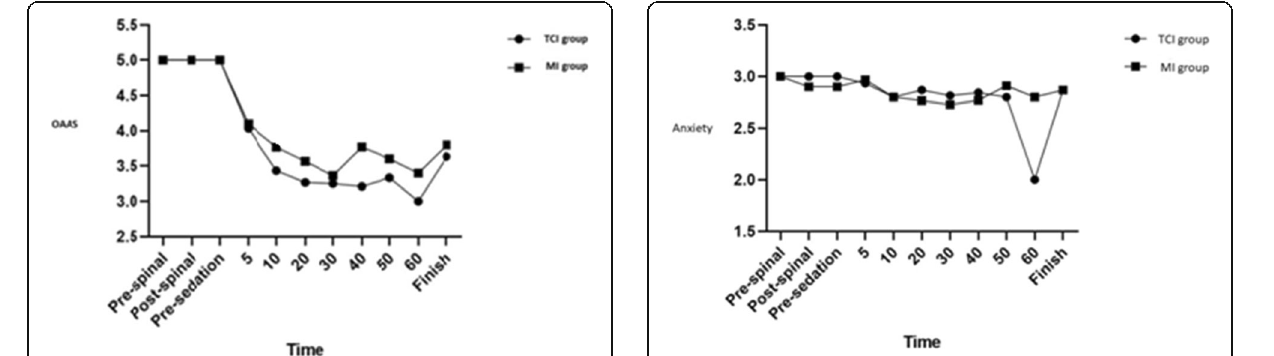
Fig. 6 Changes in Observer ’ s Assessment of Alertness and Sedation.